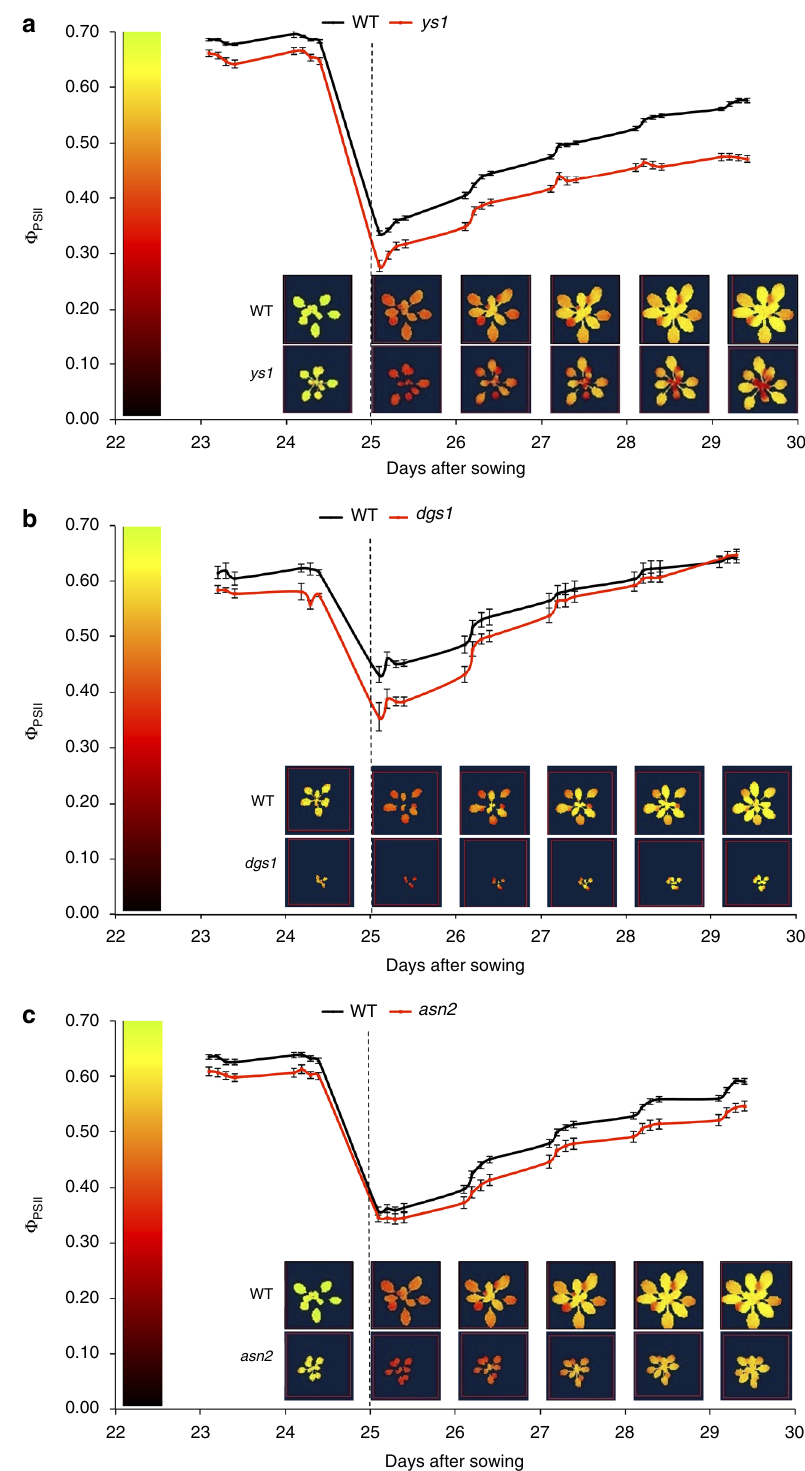
Fig. 3 Candidate gene mutant photosynthesis ef fi ciency response to increased irradiance. a – c Photosynthesis ef fi ciency ( Ф PSII ) response over time ( ± s.e.m., N = 16) and chlorophyll fl uorescence images of knock-out mutants for the a YELLOW SEEDLING 1 ( ys1 ); b DGD1 SUPPRESSOR 1 ( dgs1 ); and c ASPARAGINE SYNTHETASE 2 ( asn2 ) gene, compared to Col-0 wild-type plants (WT). The chlorophyll fl uorescence images were taken 1 h after the beginning of the photoperiod. The vertical dotted line at 25 days after sowing indicates the increase in irradiance from 100 to 550 µ mol m − 2 s −